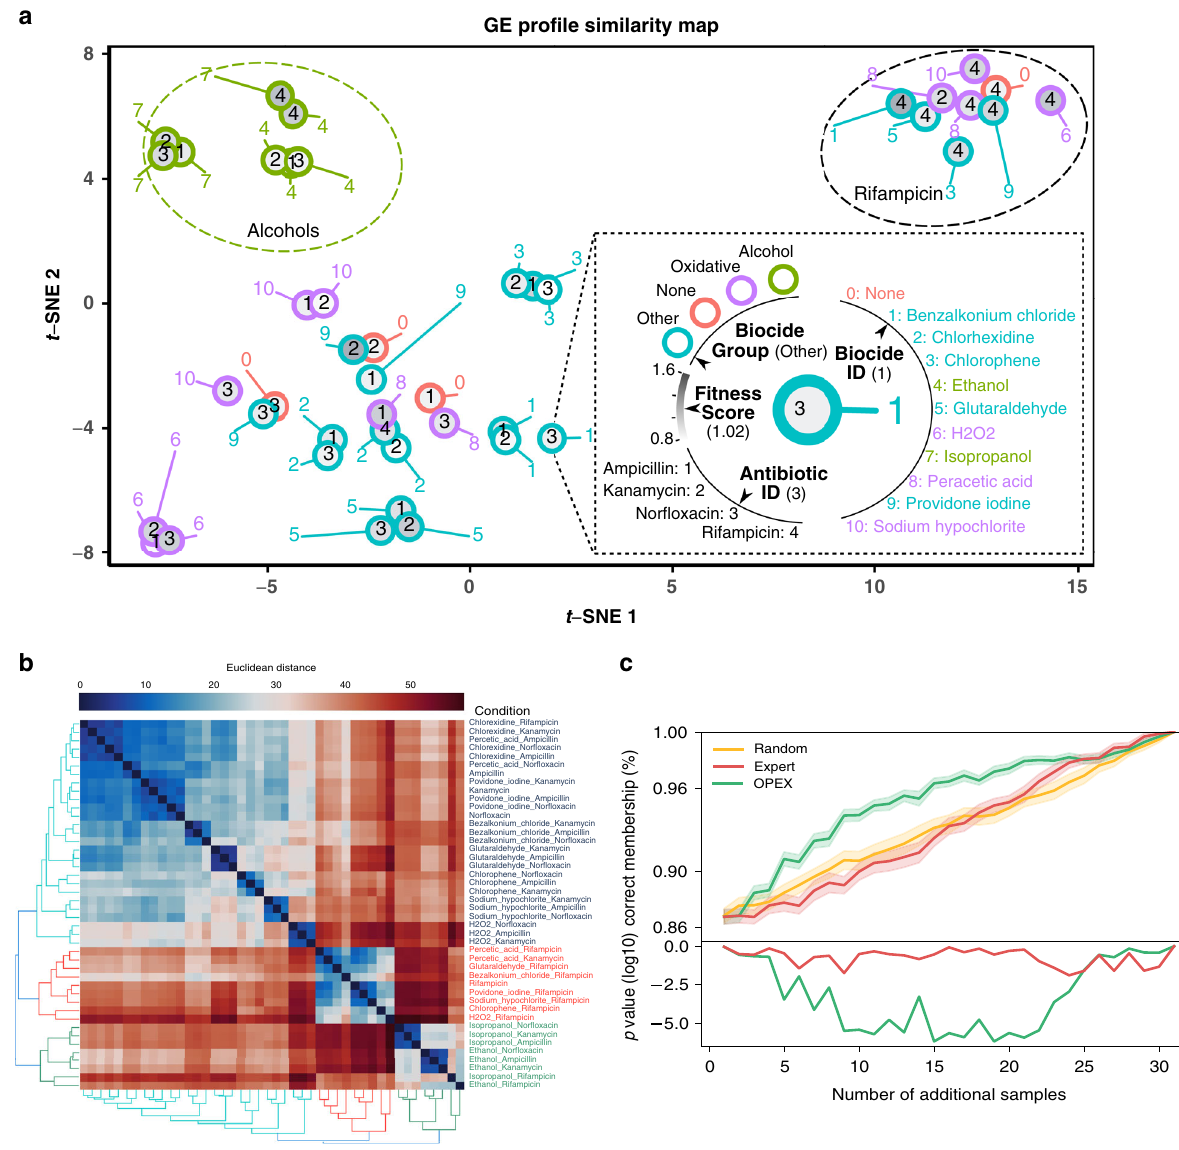
Fig. 3 OPEX accelerated the discovery of cluster memberships for the culture conditions. a A two-dimensional representation of the gene expression pro fi les of all 44 culture conditions through t-SNE, where three clusters are observed (Rifampicin, Alcohols, and Others). Each bordered circle represents a culture condition, with the border color encoding the biocide group. The grayscale color of the inner circles encodes the fi tness of E . coli under each condition. The numbers inside and outside each circle encode for the antibiotic and biocide, respectively. b Hierarchical clustering of culture conditions using the transcriptomic pro fi les for each culture condition. c Performance of OPEX in predicting cluster memberships. Starting with 15 observed culture conditions, OPEX predicts more accurately than other methods the gene expression phenotype of the remaining conditions and their respective clusters (Alcohols, Rifampicin, and Others), with p values being calculated with reference to random sampling. The shadow belt around a curve represents plus and minus standard deviation in 50 runs. The p values were calculated by a one-sided t